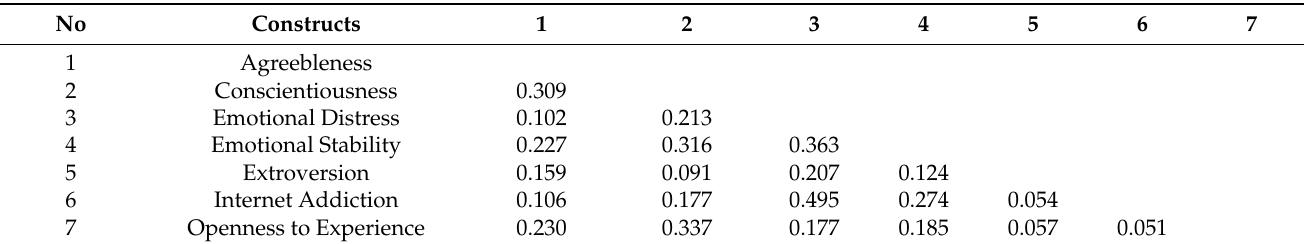
Table 2. Discriminant validity using HTMT